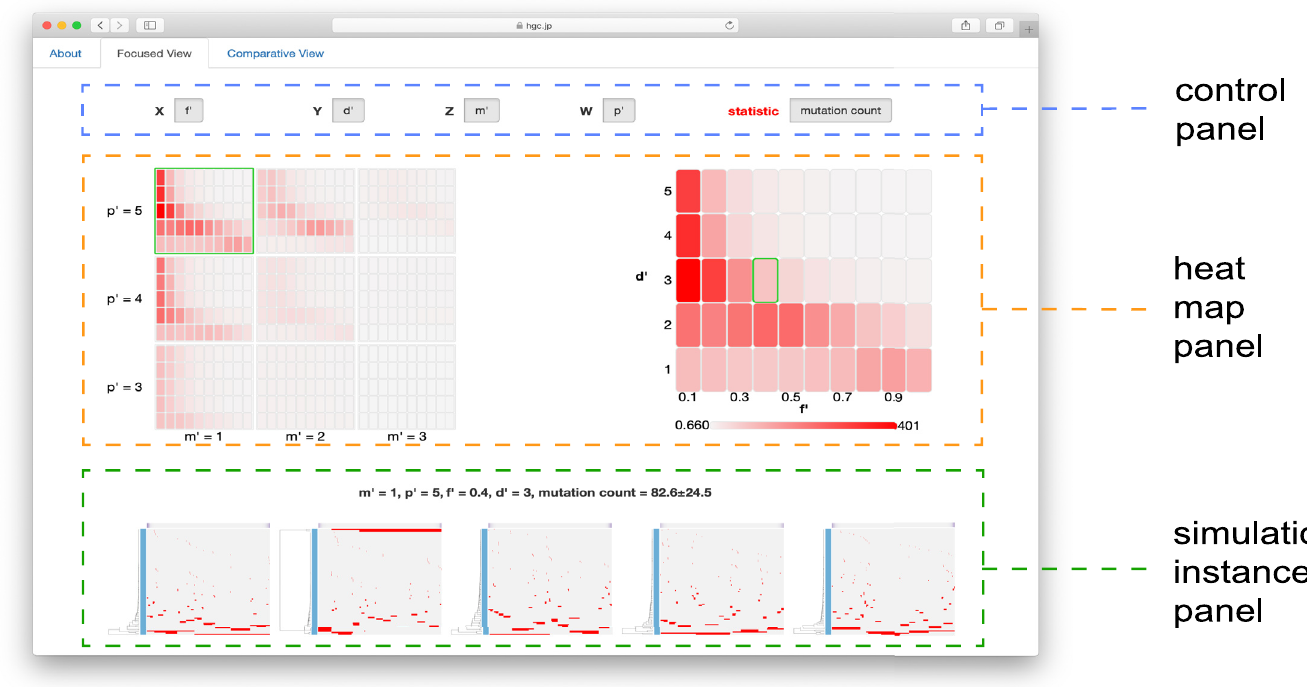
Fig 4. Focused view mode of the MASSIVE viewer. The page of the focused view mode consists of control, heat map and simulation instance panels. The control panel specifies visualization settings, the heat map panels presents heat maps for a selected statistic, and the simulation instance panel presents 5 mutation profiles from the parameter set specified by the position of the mouse cursor on the heat maps.